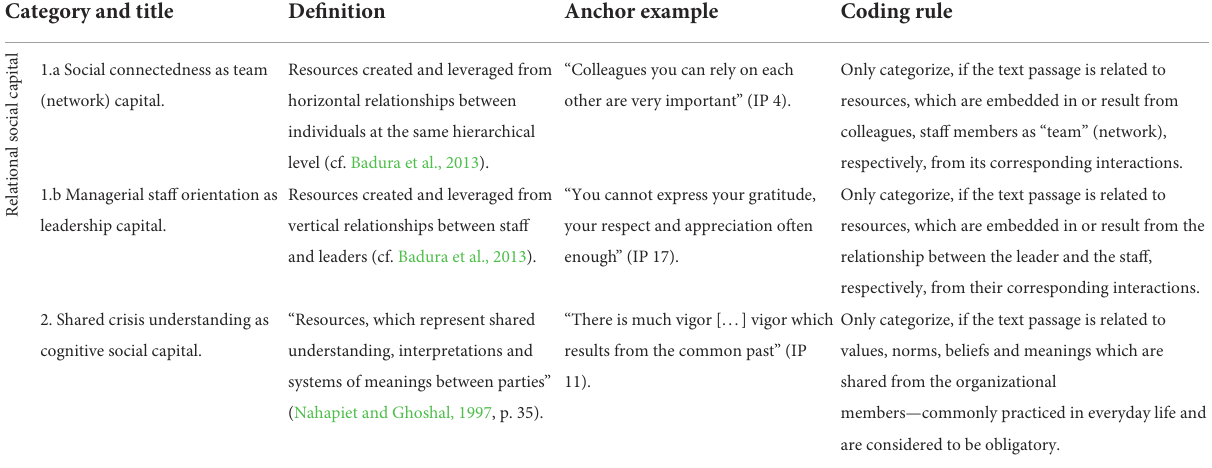
TABLE 1 Coding schema for interactional resilience mechanisms (own